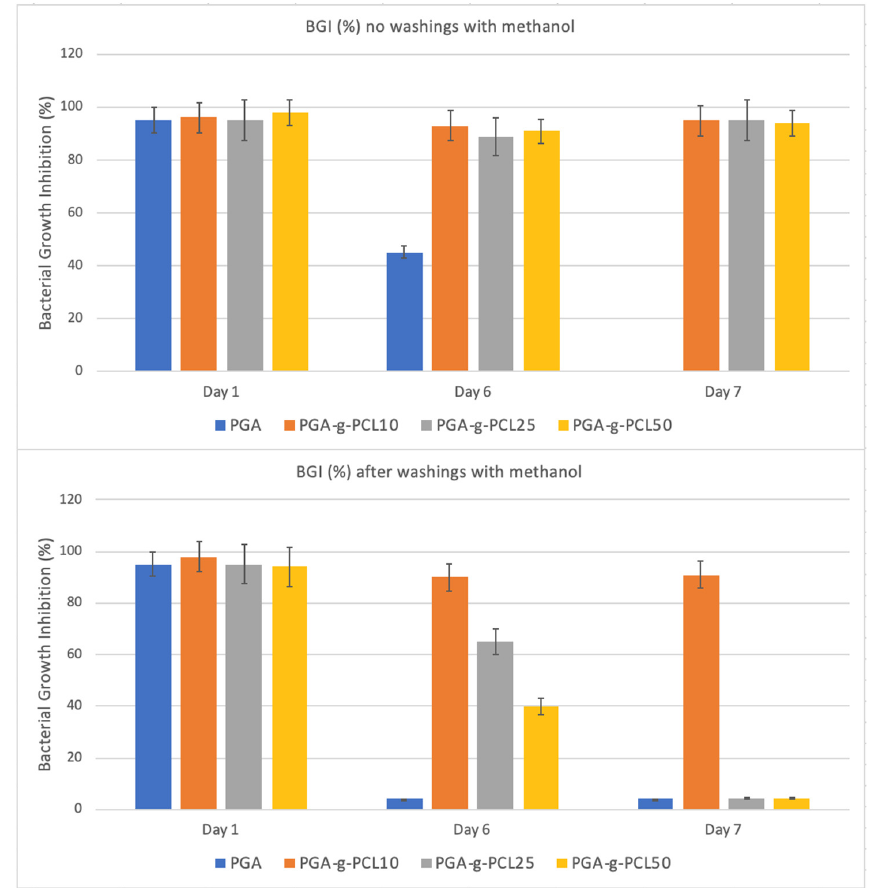
Figure 6. Bacterial growth inhibition percentage (BGI, %) of the UA-loaded nanoparticles before and after washings with methanol. Strain: Staphylococcus epidermidis .